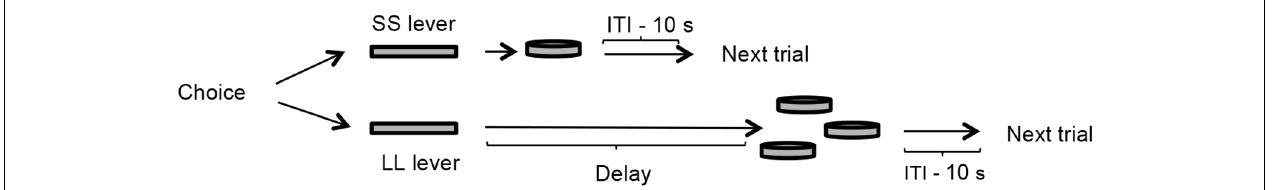
FIGURE 2 | The delay-discounting task consisted of presenting the rat two options: one that delivered one food pellet immediately (SS lever), and the other that delivered three food pellets after a delay (LL lever). After the delivery of the food pellets in both options, a 10-s ITI started, and then a new trial began. The value of the delay increased 3 s per session until a maximum of 36 s, thus during each individual session the value of the delay remained constant.